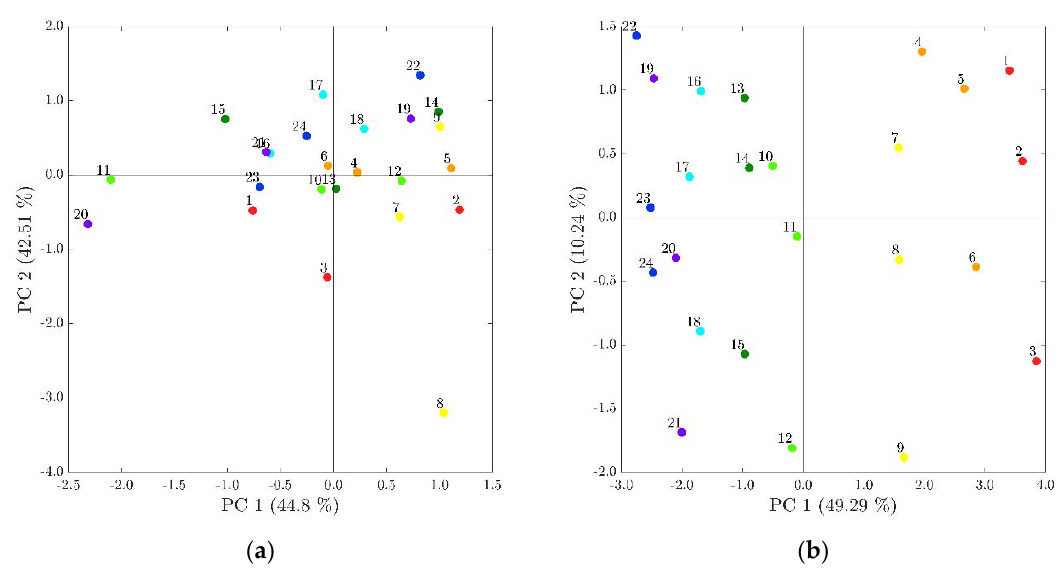
Figure 4. Full horizon PCA approach at different times. ( a ) Score plot for the full horizon principal component analysis (PCA) model at time point t = 30 min. ( b ) Score plot for the full horizon PCA model at t = 10:22 h (entire cultivation). The eight groups of replicates are indicated by color and the reactors are numbered consecutively. The variance explained by the PC is indicated in percent in parenthesis.